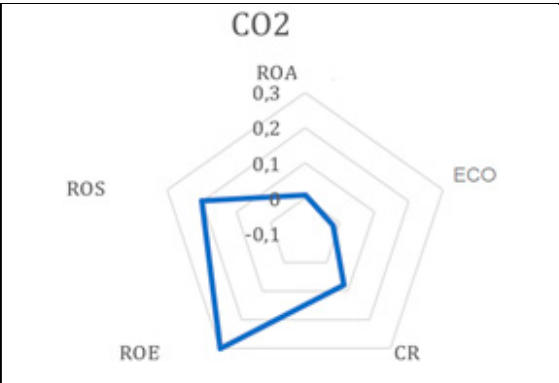
Figure 10. The degree of correlation of the greening index and financial indicators of LSPs in 2021.